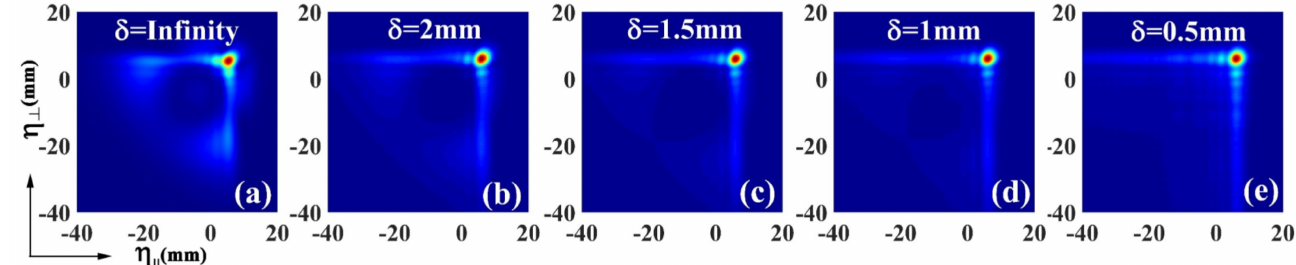
Figure 5. Density plots of the intensity distributions of a PCAB at the different propagation distances Z during propagation ( a – e ). The beam is obstructed by an opaque obstacle in the source plane. The source coherence width is δ 0 = 1 mm.